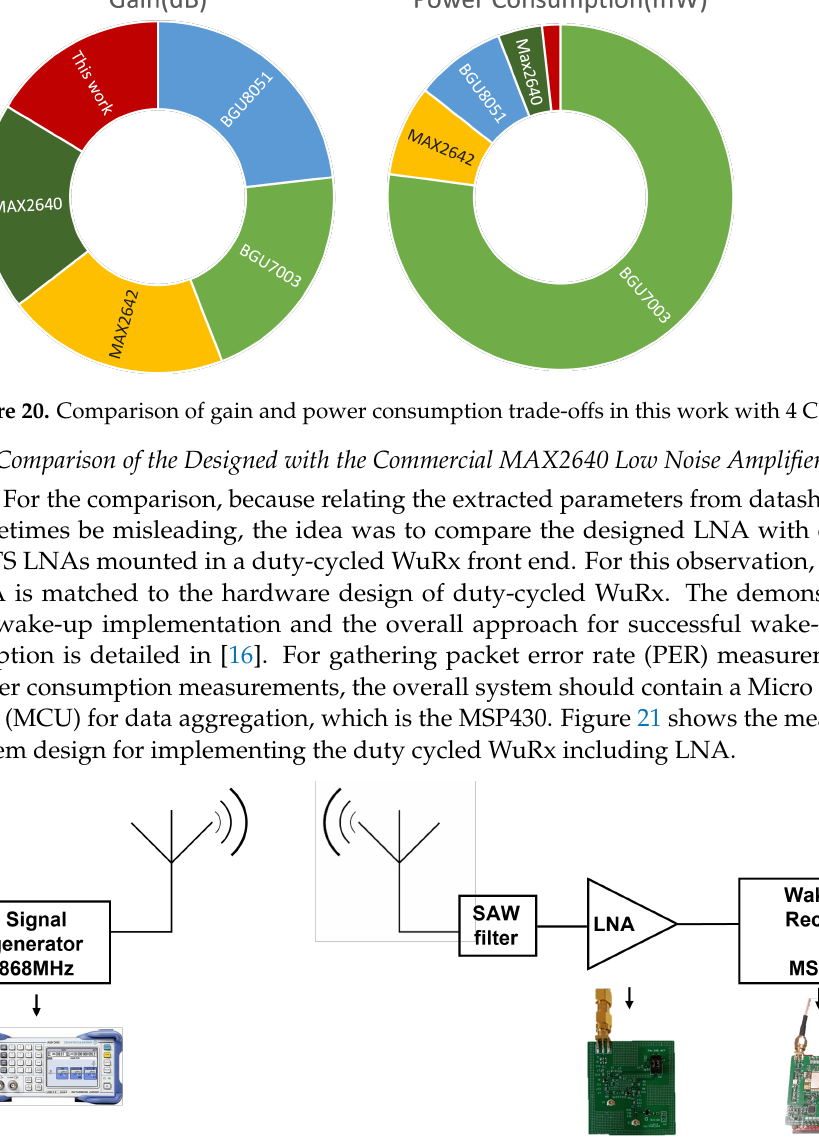
Figure 21. Measurement setup for integration of LNA in duty cycled Wake-up receiver.